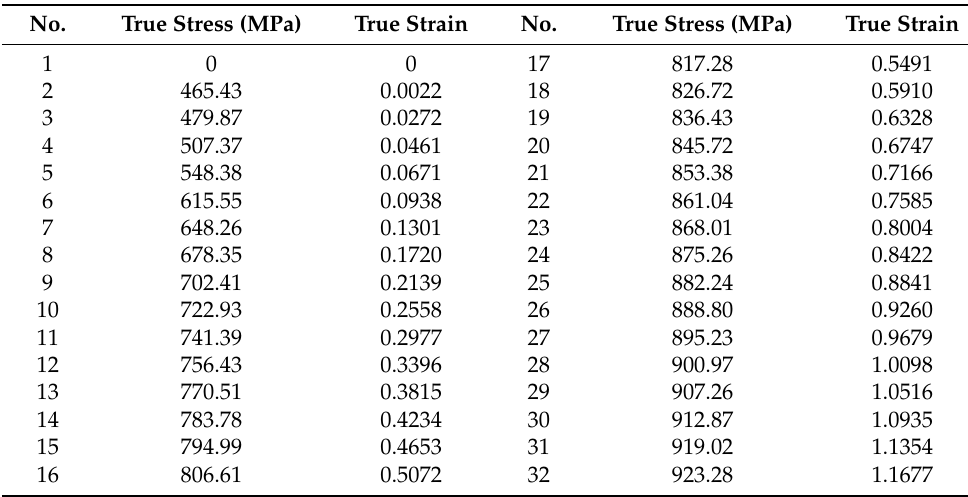
Table 4. Datapoints of X65 true stress–strain inputted into ANSYS. Table 3. Results of mesh convergence study.